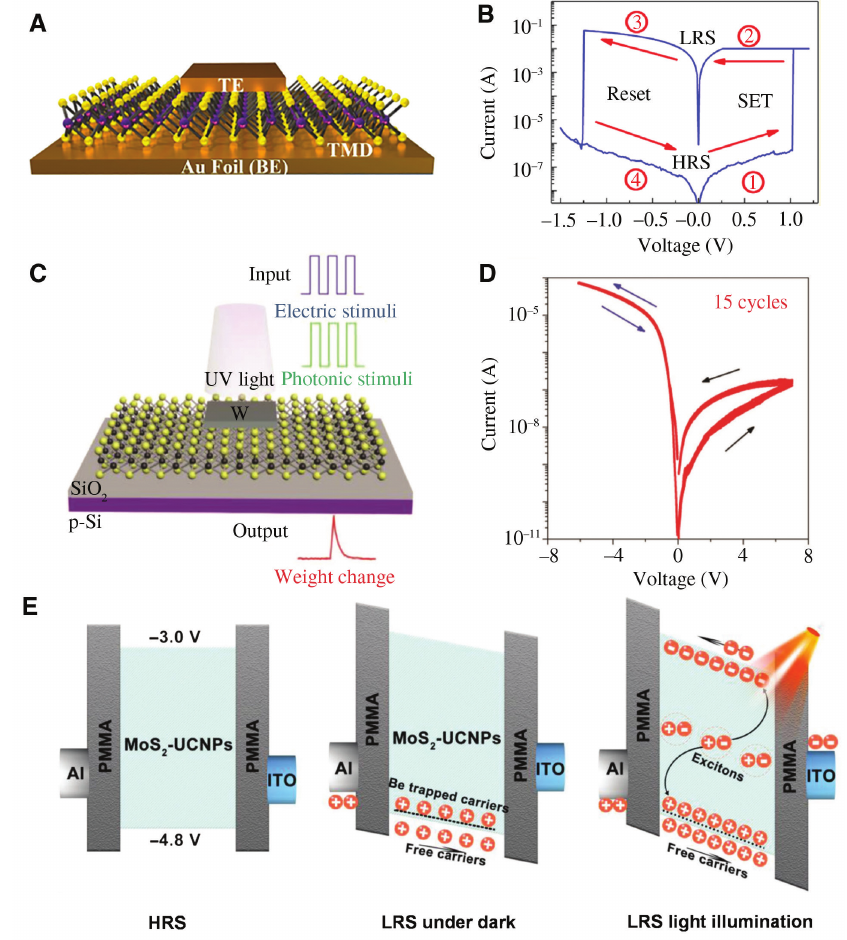
RRAM and photonic 2